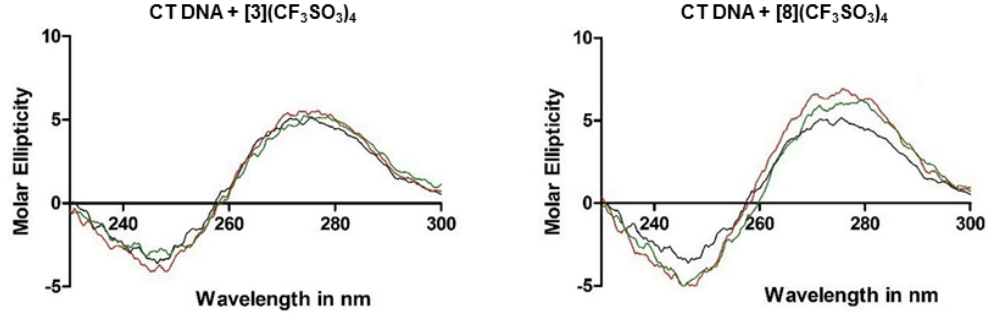
Figure 7. CD spectra obtained on addition of a 1:0.5 (  ) and a 1:1 (  ) ratio of CT DNA to metalla-rectangles 3 and 8 , CT DNA alone ( 